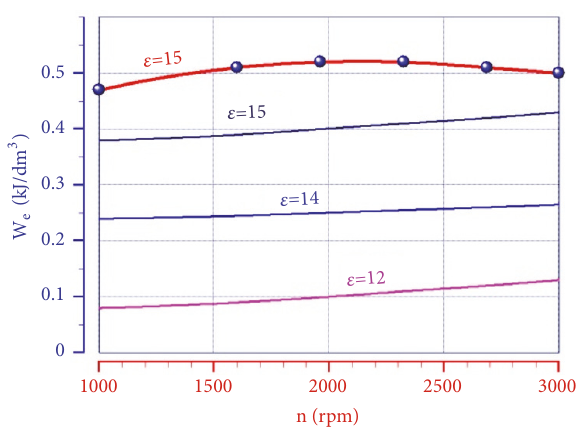
Figure 11: Selection of the optimal value of the (CR) for engine operating with the minimal NO